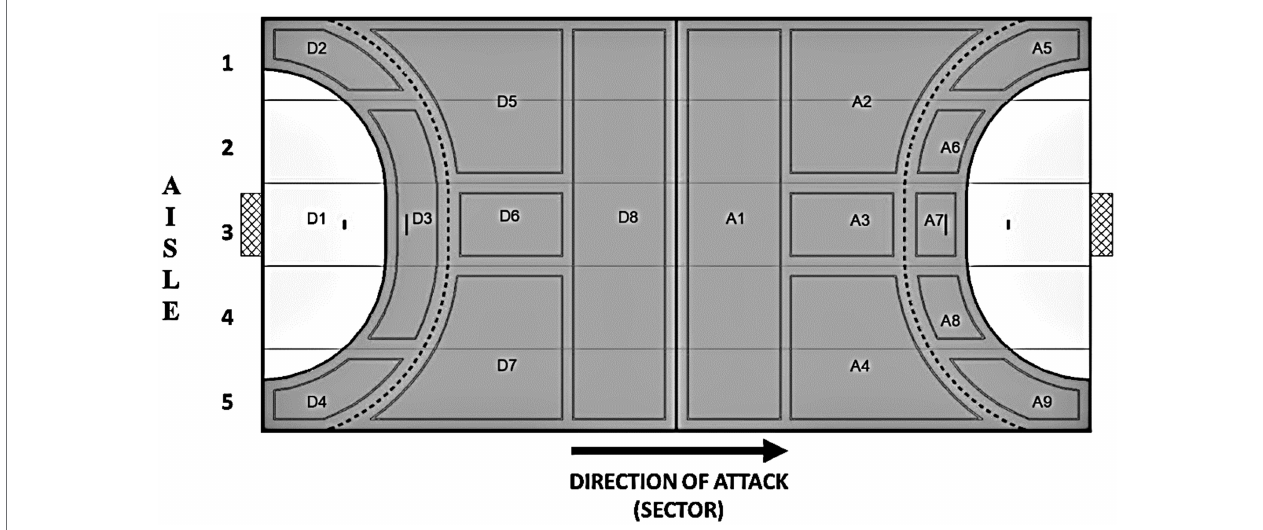
FIGURE 1 | Field zones divided into 17 zones and five aisles with the numbering of zones designated according to the direction of the attack (Ferrari et al., 2020) D, Defense and A,